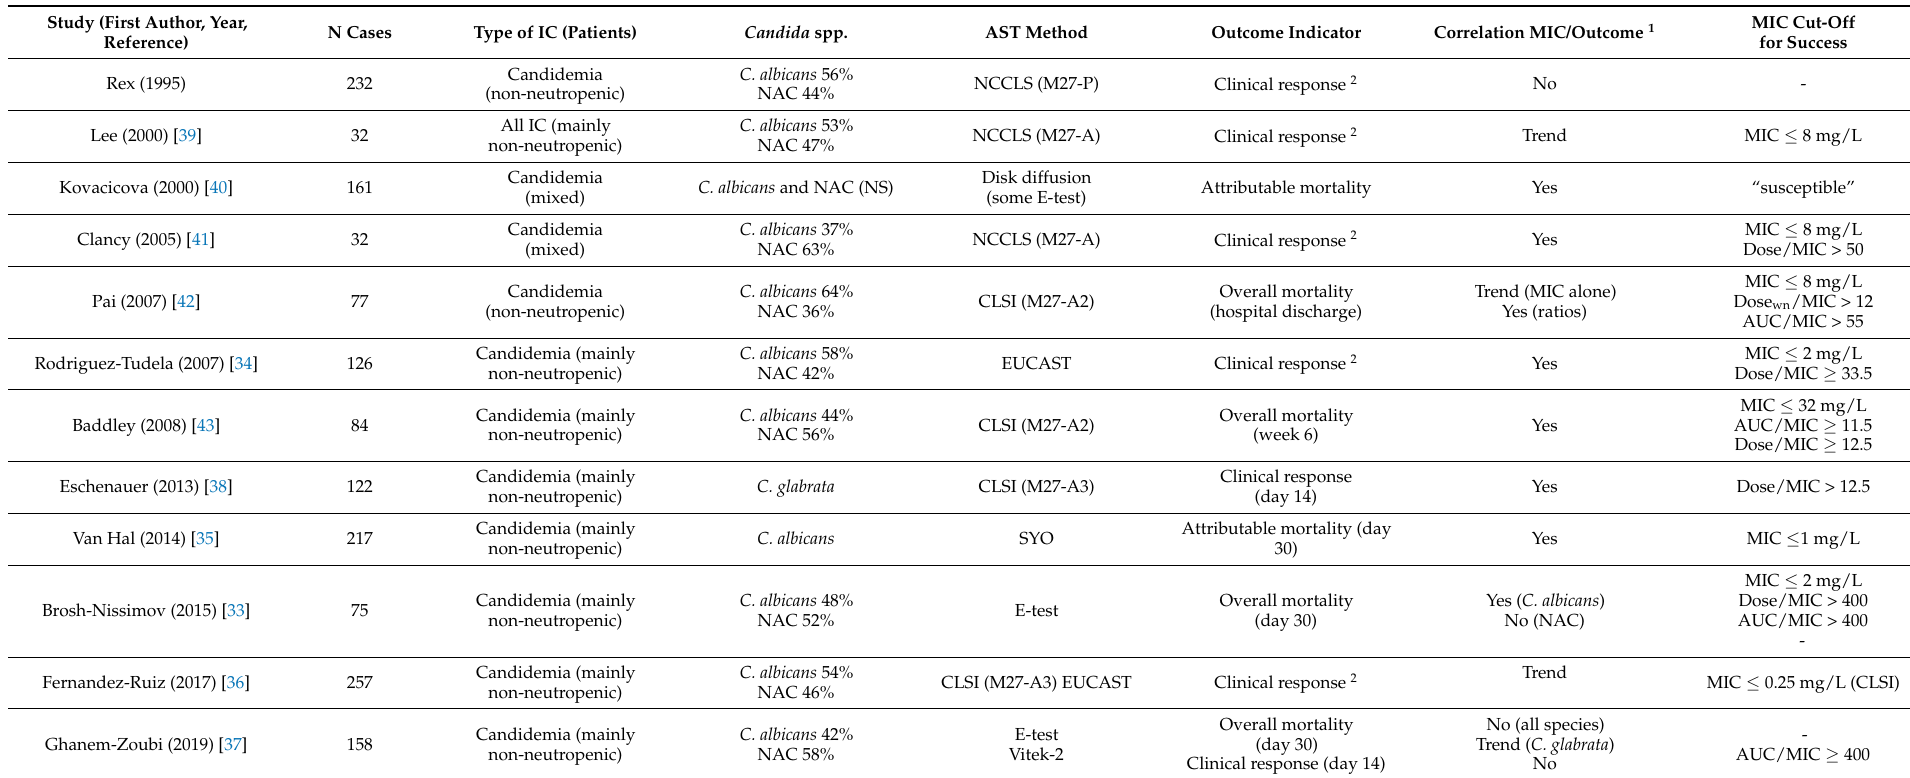
Table 2. Clinical studies correlating fluconazole minimal inhibitory concentrations (MIC) and outcome of invasive candidiasis